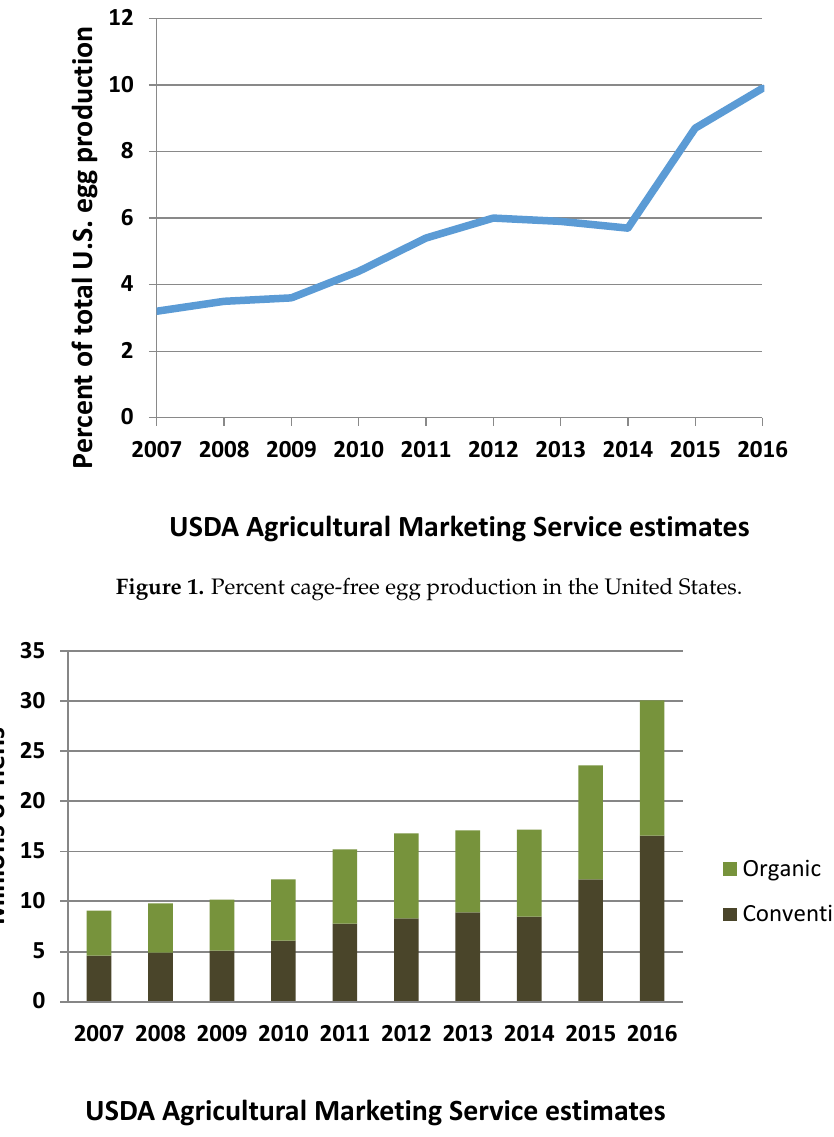
Figure 2. Number of cage-free laying hens in the United States.